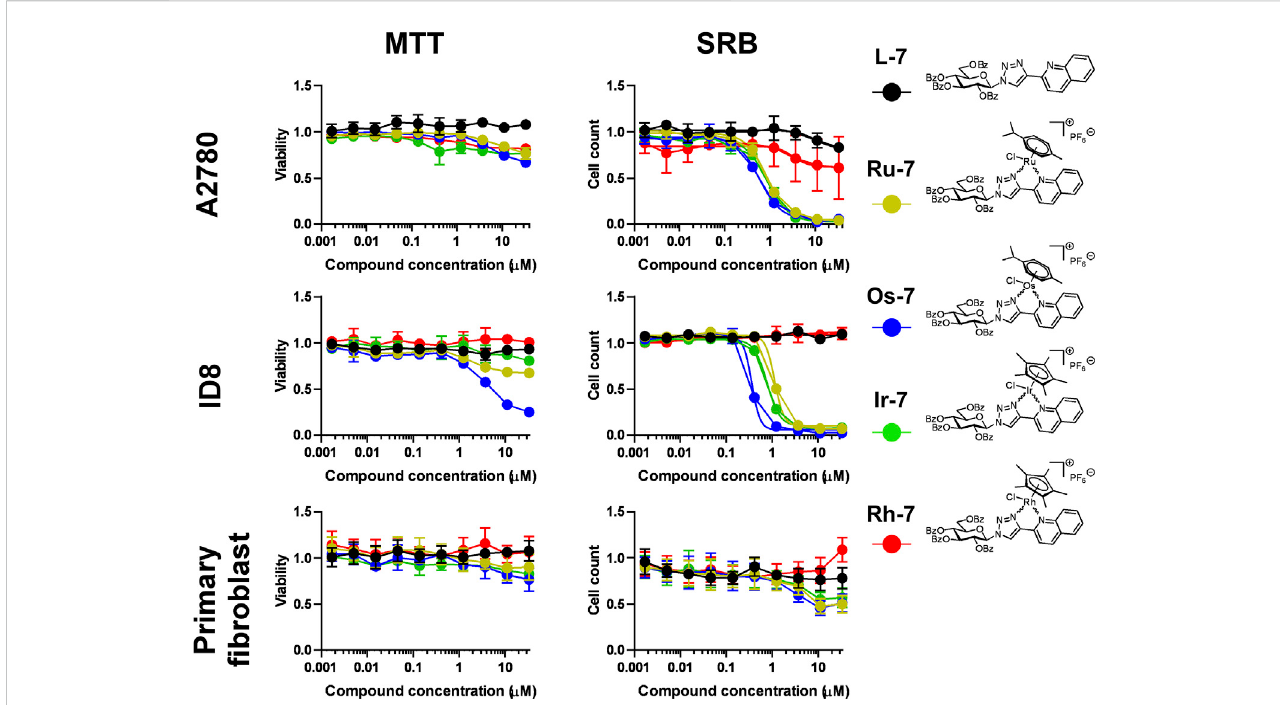
FIGURE 5 Assessmentofquinoline-containingcomplexes Ru-7,Os-7,Ir-7,Rh-7 andthecorrespondingfreeligand L-7 forcytotoxicandcytostatic activity.3×10 3 A2780 cells, 2 × 10 3 ID8 cells and 4 × 10 3 primary fi broblasts were plated to 96 well plates. Cells were treated with the compounds in the concentrations indicated for either 4 h for an MTT assay or for 48 h for an SRB assay. Data is represented as average ± SD, from three biological replicates; individual assays were performed in duplicates. Values were normalized for vehicle treated cells, absorbance for vehicle treated cells equals to 1. Statistical signi fi cance wasassessed usingtwo-way ANOVA testcomparingthefreeligandand eachcomplexas acomplex-ligandpair.Before thetestnormalitywasassessed using the D ’ Agostino-Pearson test. The ID8 SRB Ir-7+L-7 dataset had lognormal distribution. The A2780 MTT Ru-7+L-7 , A2780 SRB Os-7+L-7 , Fibroblast SRB Ru- 7+L-7 were transformed using the Box-Cox method to achive normal distribution. All other datasets had normal distribution. For better visibility the p values are presented in an excel sheet at https:// fi gshare.com/s/2c942a812caea8869a67. Non-linear regression was performed on the A2780 SRB and the ID8 SRB